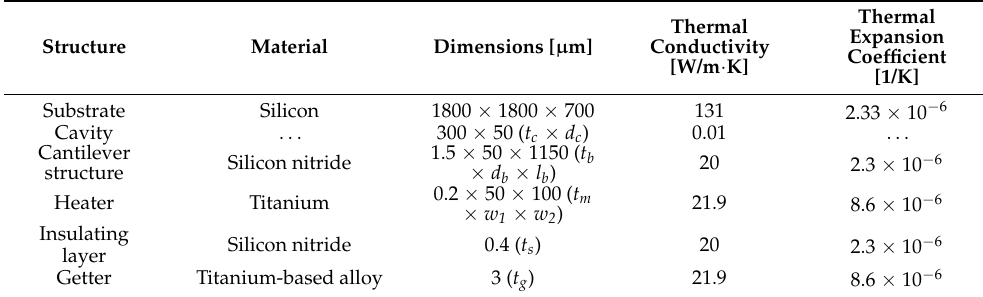
Table 1. Floating structure